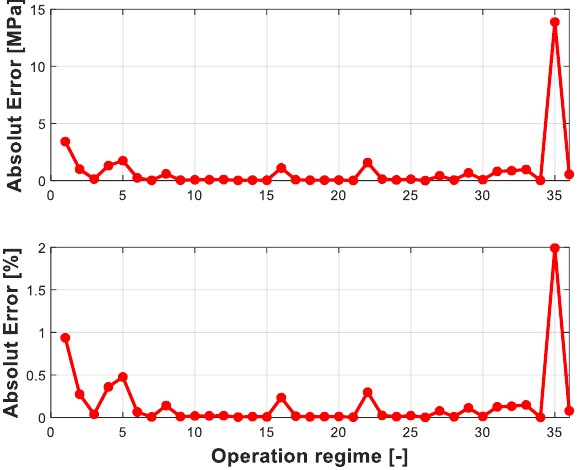
Figure 12. Estimated errors of the predicted data by NN and FEM.